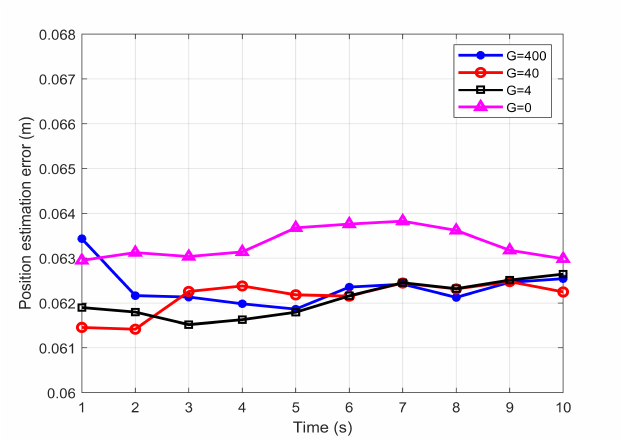
Figure 7. The influence of the adversary behavior of the intruder on position